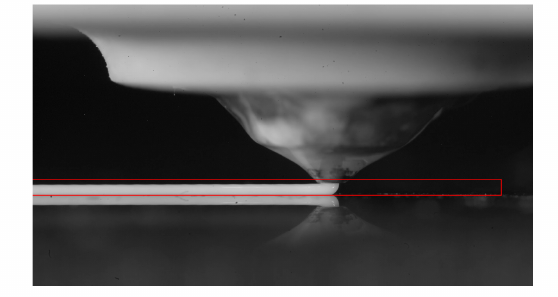
Figure 4. Full resolution snapshot of a high-speed video.